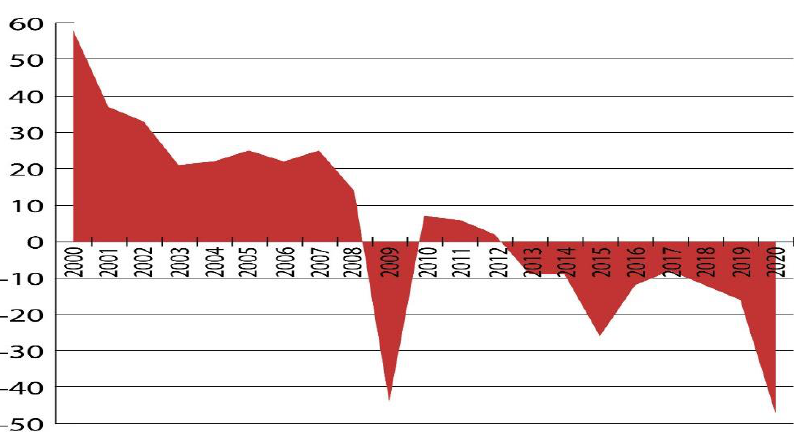
Figure 2. Decline of advertising revenues in Russian print media in 2000–2020, %%. Elaborated by the authors based on the “Market Volumes” section on the Association of Russian Communications Agencies portal (AKAR 2021c).